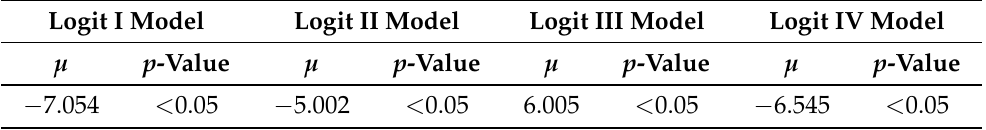
Table 9. Respective µ values of logistic regression models.